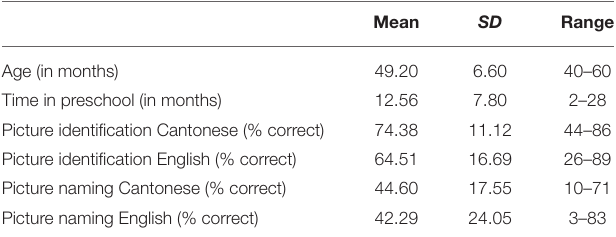
TABLE 1 | Summary of children’s demographic information and vocabulary